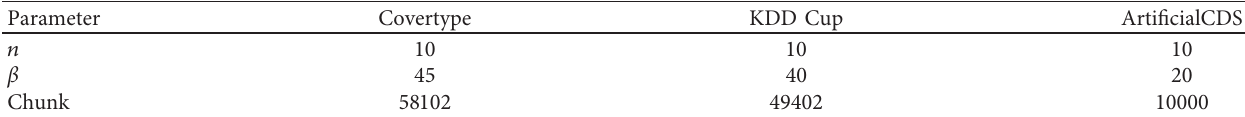
Table 3: Parameter settings of the three compared algorithms.